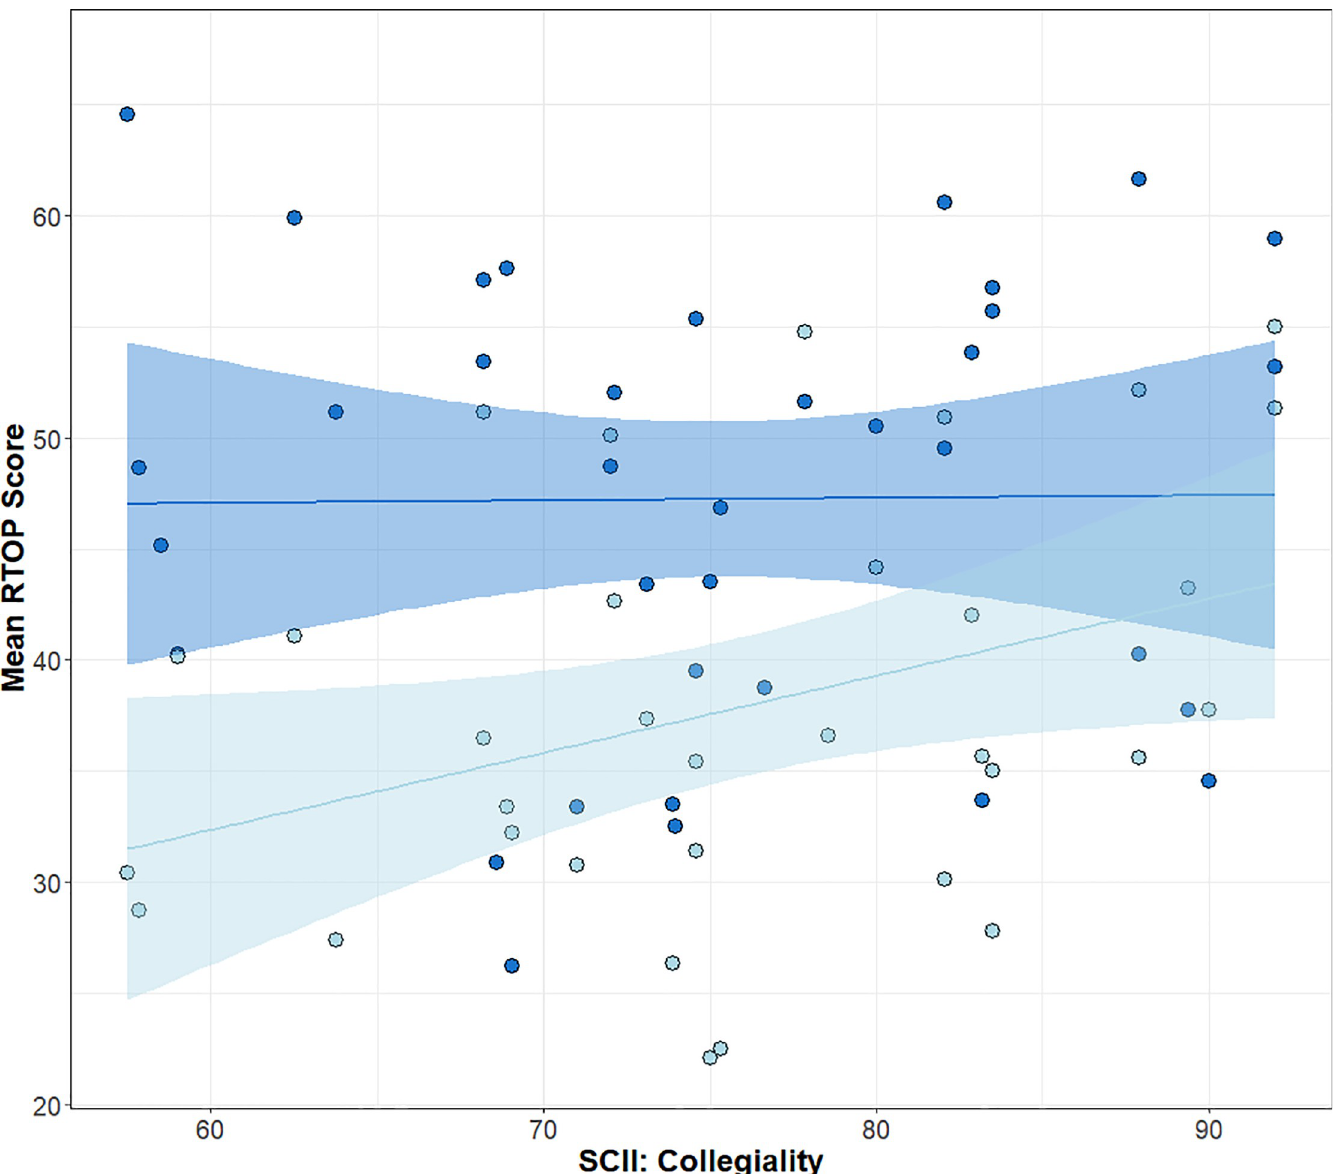
Fig 5. Linear regression of SCII: Collegiality and mean RTOP score for FIRST IV faculty (Dark blue; P = 0.95, r 2 = 0.0) and comparison faculty (Light blue; P = 0.0001, r 2 = 0.1). The blue bands represent the 95% confidence intervals (N = 70 faculty).